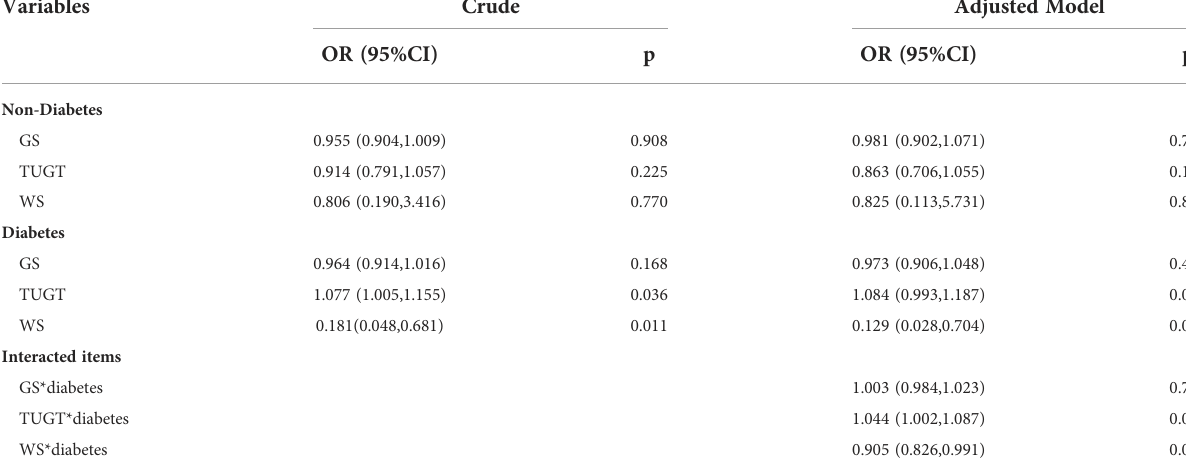
TABLE 2 Logistic regression analysis of physical performance and MCI in the non-diabetic and diabetic hemodialysis patients. Variables